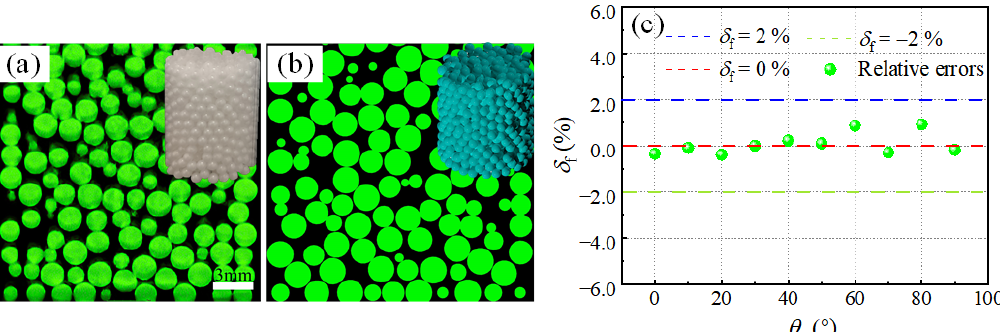
Figure 9. Verification of DEM model by fractal dimension: ( a ) CT image; ( b ) cross-section image of simulated model; ( c ) relative error of fractal dimension.